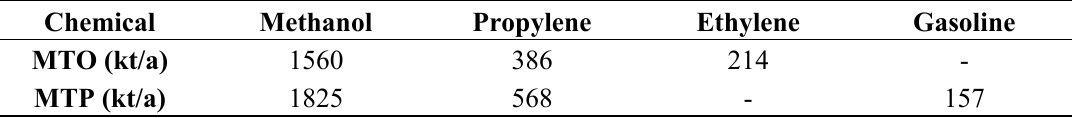
Figure 4. Flowsheet for the MTO Process. Table 1. Input/output rates for the base case